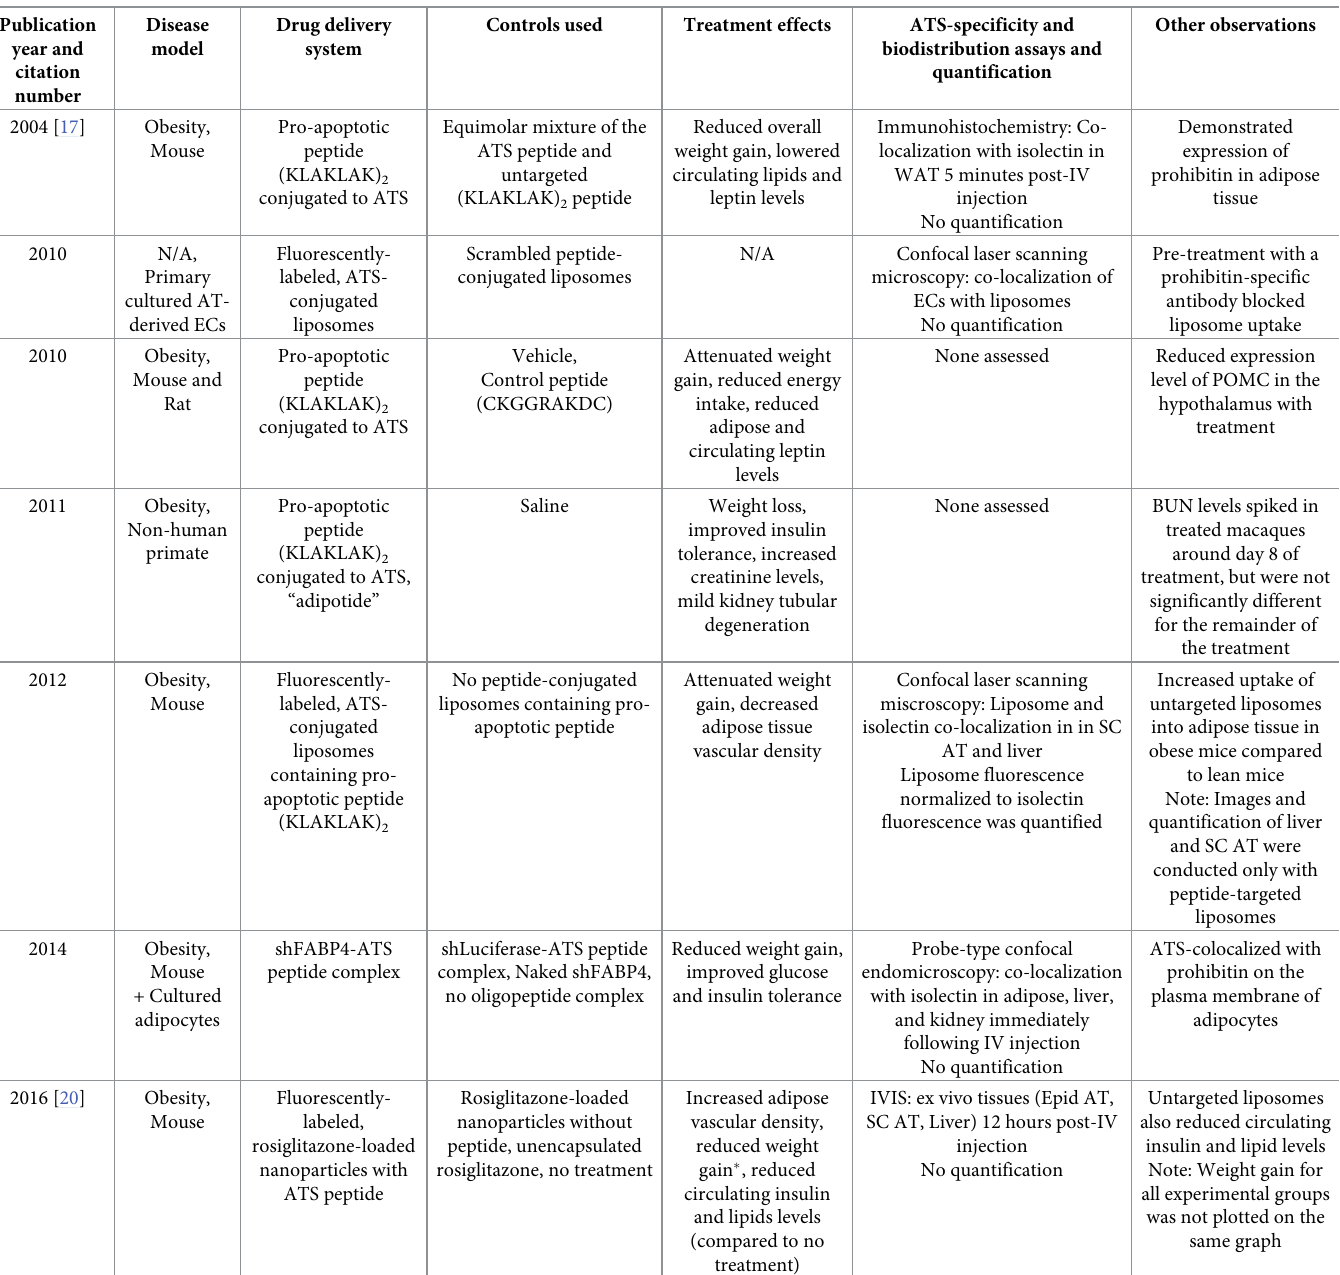
Table 1. Adipose targeting sequence publication